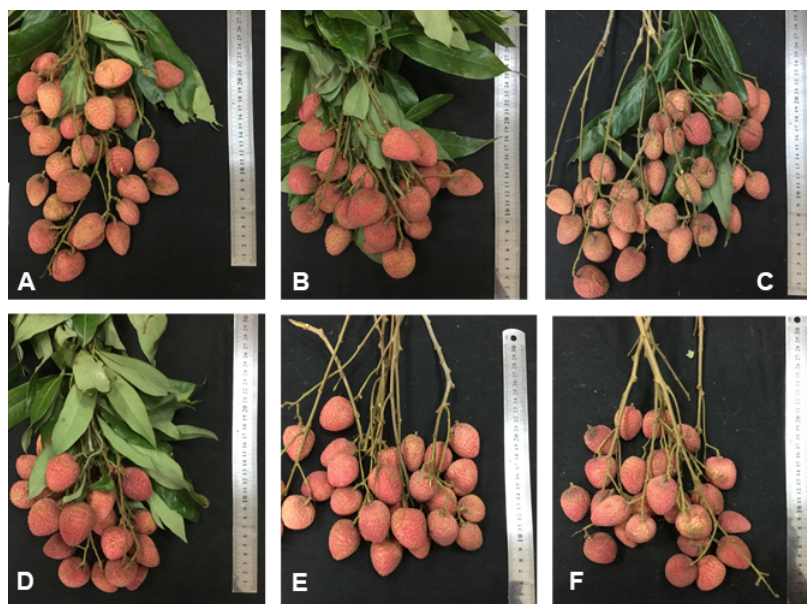
Fig. 1 Photographs of harvested litchi fruits treated with varying doses of chitosan: ( A ) control (treated with water only); ( B ) 100 µg L −1 ; ( C ) 250 µg L −1 ; ( D ) 500 µg L −1 ; ( E ) 1,000 µg L −1 chitosan; ( F ) commercial fungicide-treated litchi.